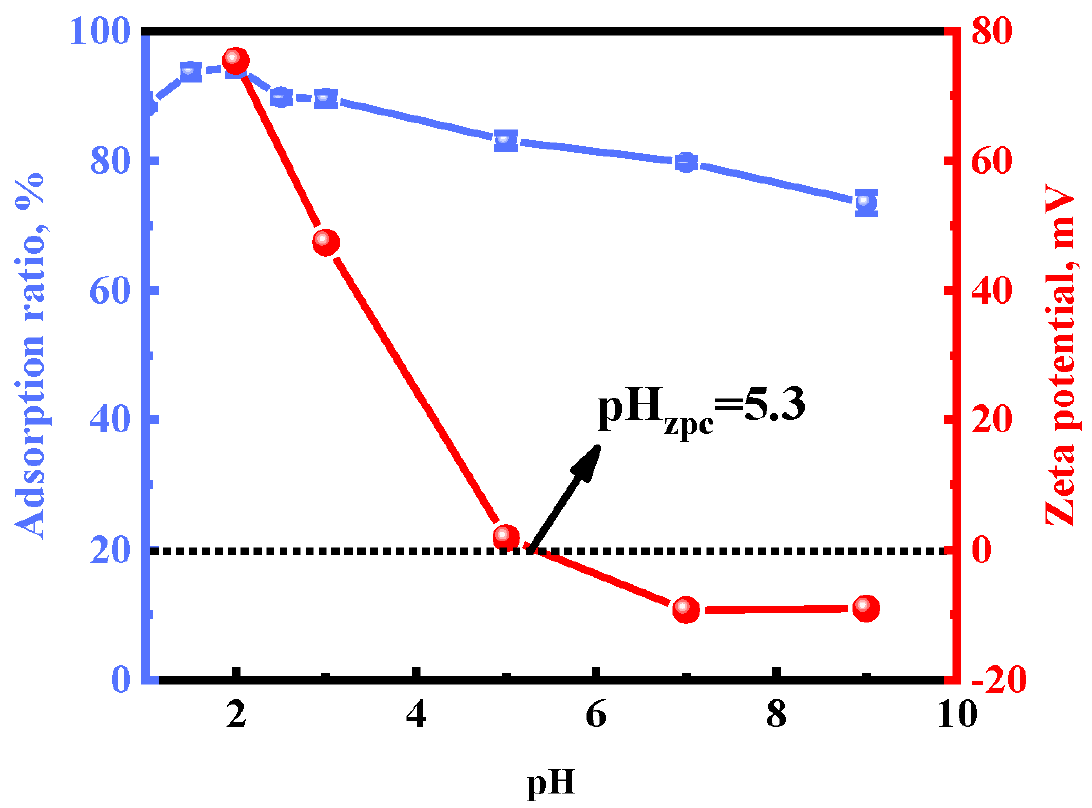
Figure 5. Effects of pH and zeta potential of [HMIm] + [BF 4 ] −